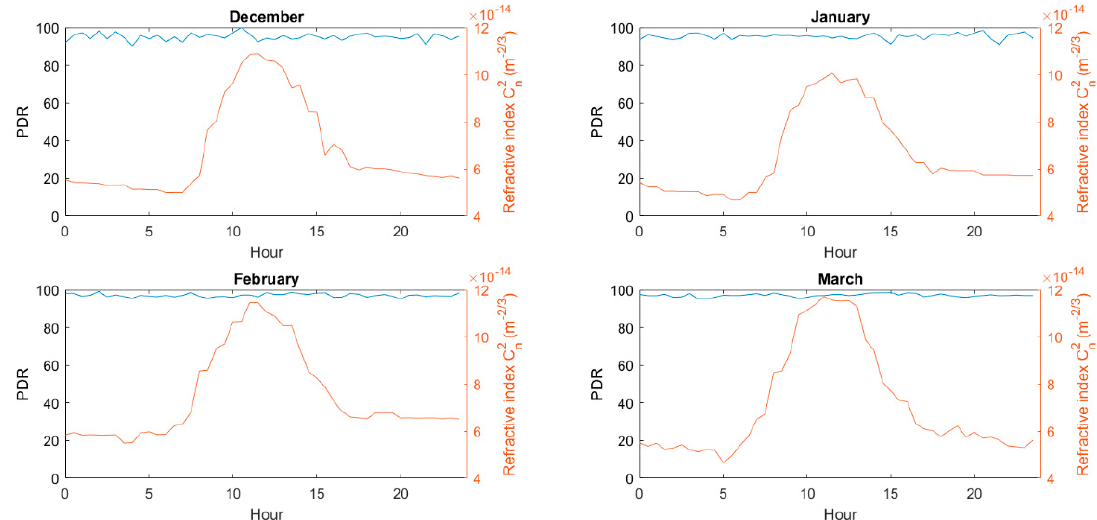
Figure 7. Comparison of the Refractive index variations for the months of December, January, February and March according to Bendersky, Kopeika, and Blaunstein (BKB) model in Qatar with FSO’s PDR during those months.